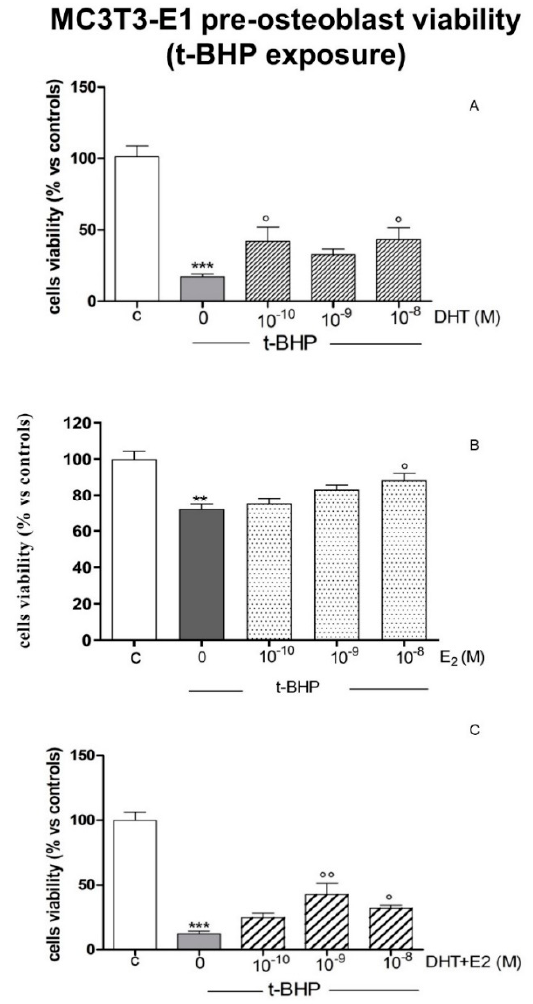
Figure 1. Effects of steroids on counteracting t-BHP-induced oxidative stress in pre-osteoblast MC3T3-E1 cells. Beneficial effects of steroids (10 − 10 –10 − 8 M) on t-BHP-induced cytotoxicity in MC3T3-E1 cells. Cells were pre-treated with E2 or DHT, or a combination of both (doses between 10 − 10 M to 10 − 9 M), 24 h before being treated with t-BHP (250 µ M for 3 h). Cell viability was measured by MTT assay 2 h after treatment. ( A ): effects of DHT on t-BHP-induced cytotoxicity in MC3T3-E1 cells; ( B ): effects of E2 on t-BHP-induced cytotoxicity in MC3T3-E1 cells; ( C ): effects of a co-treatment E2 + DHT (both at 10 − 8 M and 10 − 9 M) on t-BHP-induced cytotoxicity in MC3T3-E1 cells. Column C represents the control (w/o steroids treatment and w/o t-BHP exposure), column 0 represents the t-BHP group w/o steroids. Columns 10 − 10 , 10 − 9 , 10 − 8 represent the cells treated with increasing doses of steroids and exposed to t-BHP. Data are presented as the mean values ± SEM of six replicates within a single experiment. The experiment was repeated three times. Differences between groups were evaluated by one-way ANOVA, followed by Bonferroni post-hoc test. ** p < 0.01; *** p < 0.001 vs. control. ° p < 0.5; °° p < 0.01 vs. t-BHP.